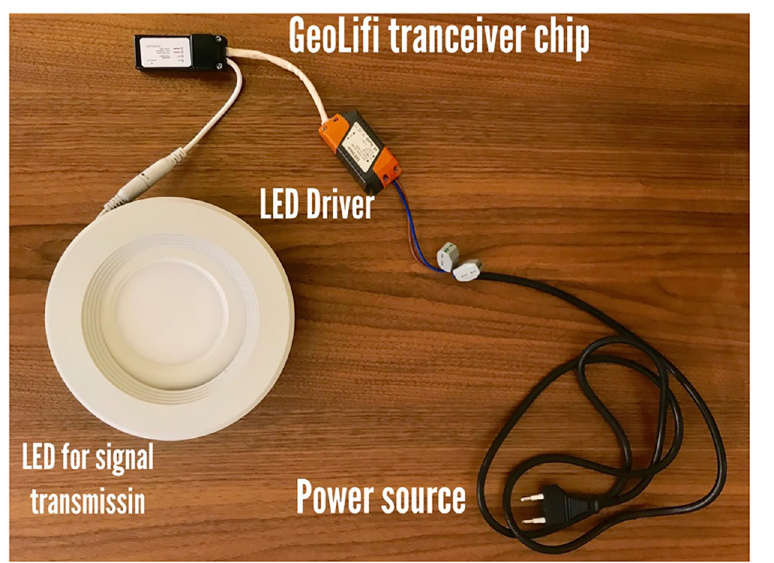
Fig 4. GeoLiFi development kit (camera